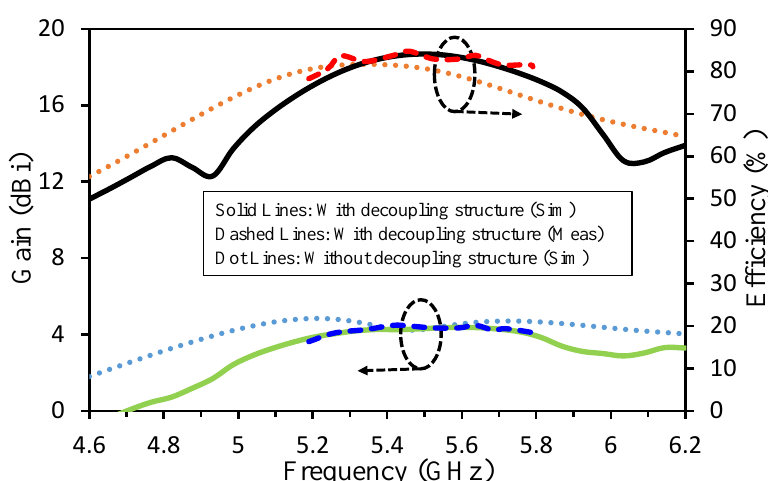
Figure 12. Simulated (with and without decoupling structure) and measured (with decoupling structure) gain and efficiency of the antenna.